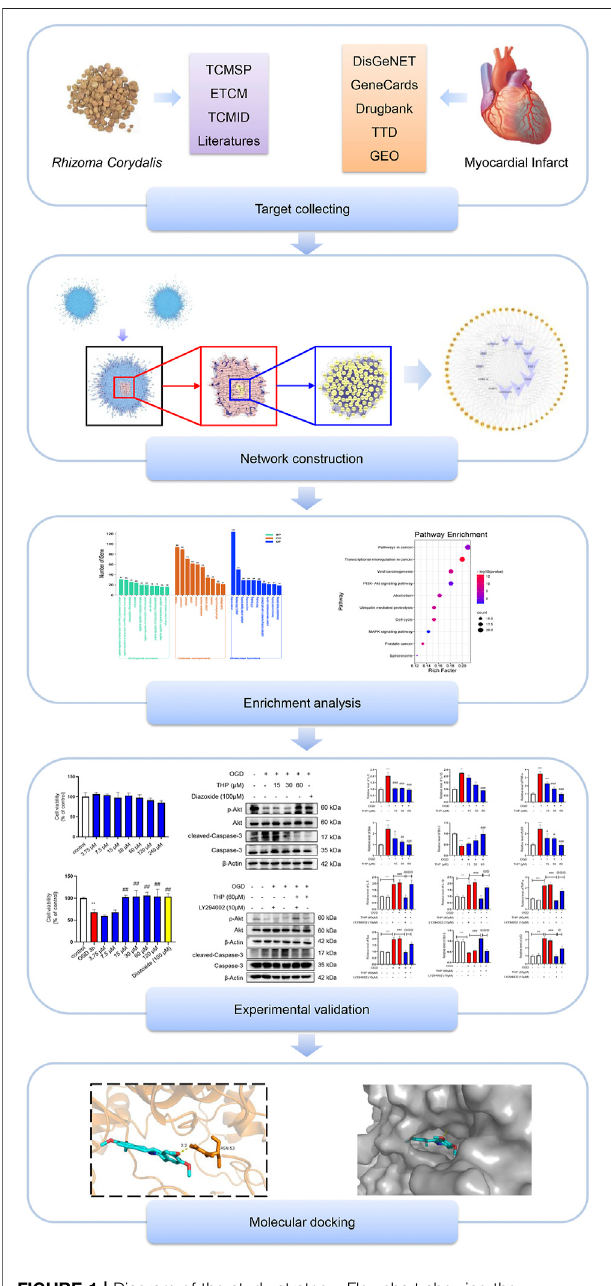
FIGURE 1 | Diagram of the study strategy. Flowchart showing the combination of network pharmacology technology, experimental validation, and molecular docking used in this